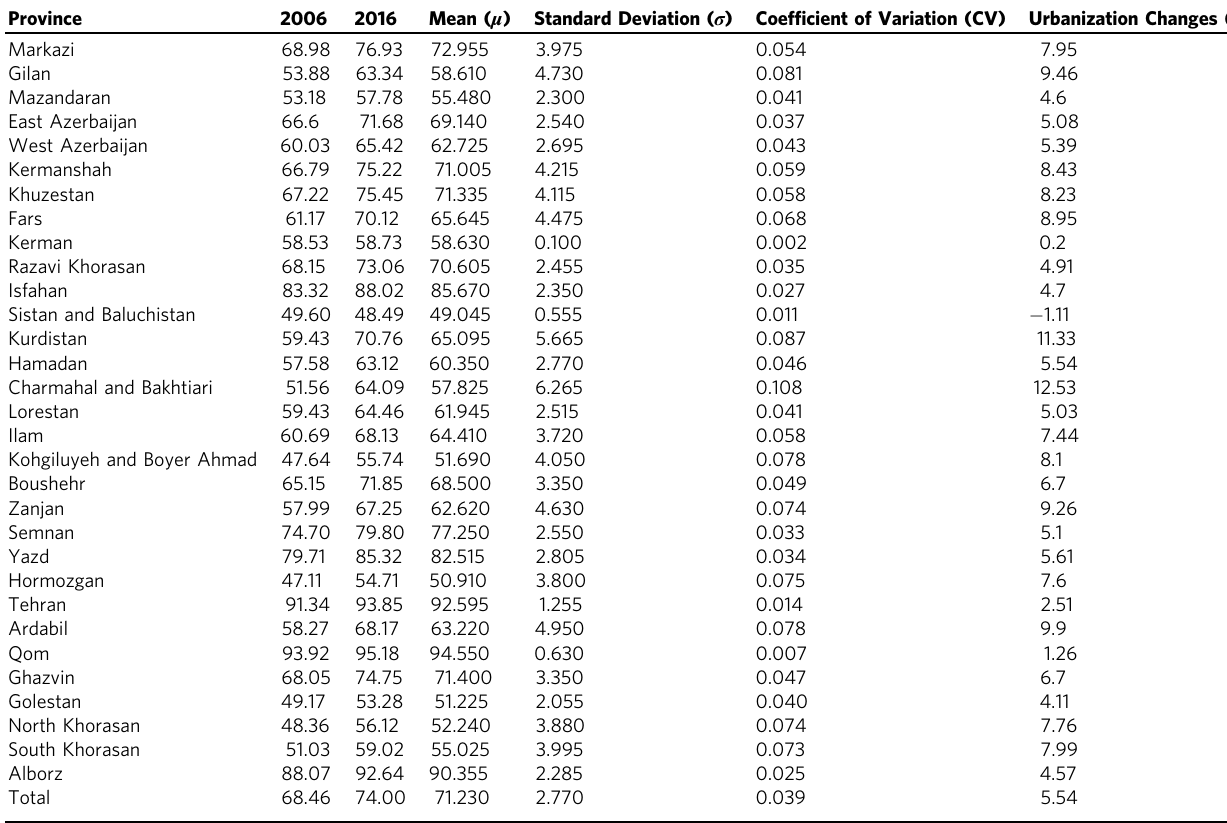
Table 3 Urbanization coef fi cient of iranian provinces in 2006 and 2016.